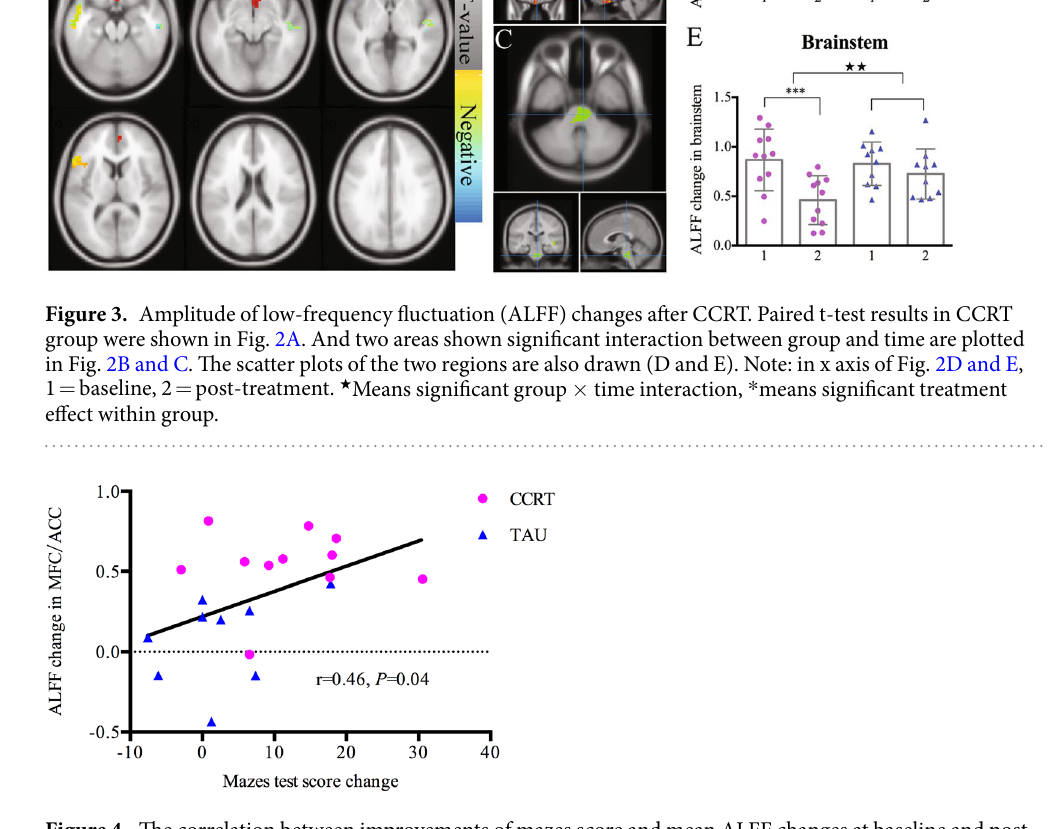
Figure 4. The correlation between improvements of mazes score and mean ALFF changes at baseline and post- treatment in combined CCRT and TAU